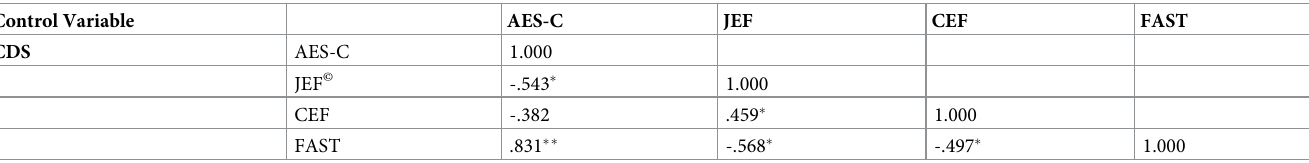
correlated significantly with the AES-C and FAST, while CEF correlated only with FAST. This analysis also showed that the measures of negative symptoms (PANSS negative and BNSS) cor- related with the apathy measure and that PANSS cognitive and PANSS total score correlated with JEF © . Notably, the CEF did not correlate with any negative symptom measure. Depres- sion did not alter the correlation coefficients between apathy, cognitive measurements, and functional outcome (Table 3).